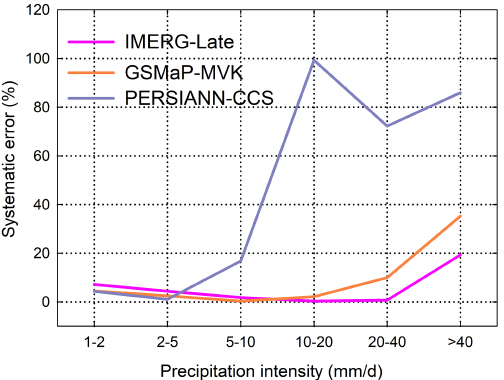
Figure 8. Systematic errors of the three satellite-only global precipitation estimates (i.e., IMERG-Late, GSMaP-MVK, and PERSIANN-CCS) at a spatial resolution of 0.5 ◦ and daily temporal resolution under different rainfall intensities. Note that the precipi- tation intensity categories are from references.